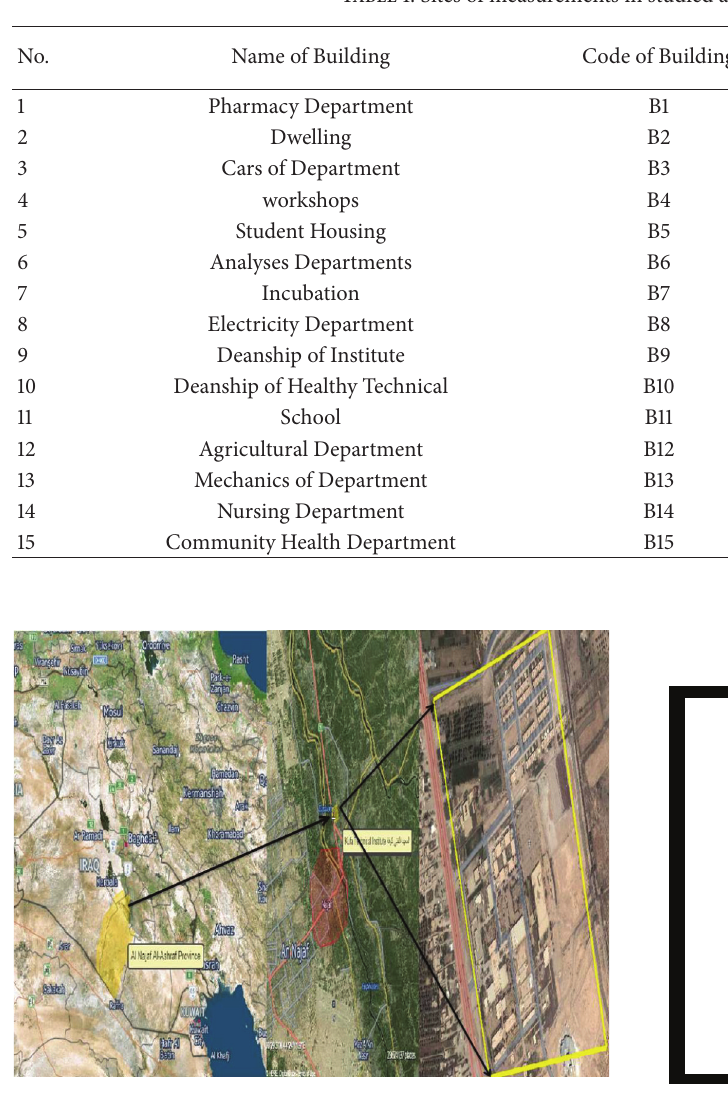
Figure 1: Map of Kufa Technical Institute. Figure 2: Measurement chamber of the RAD-7 detector